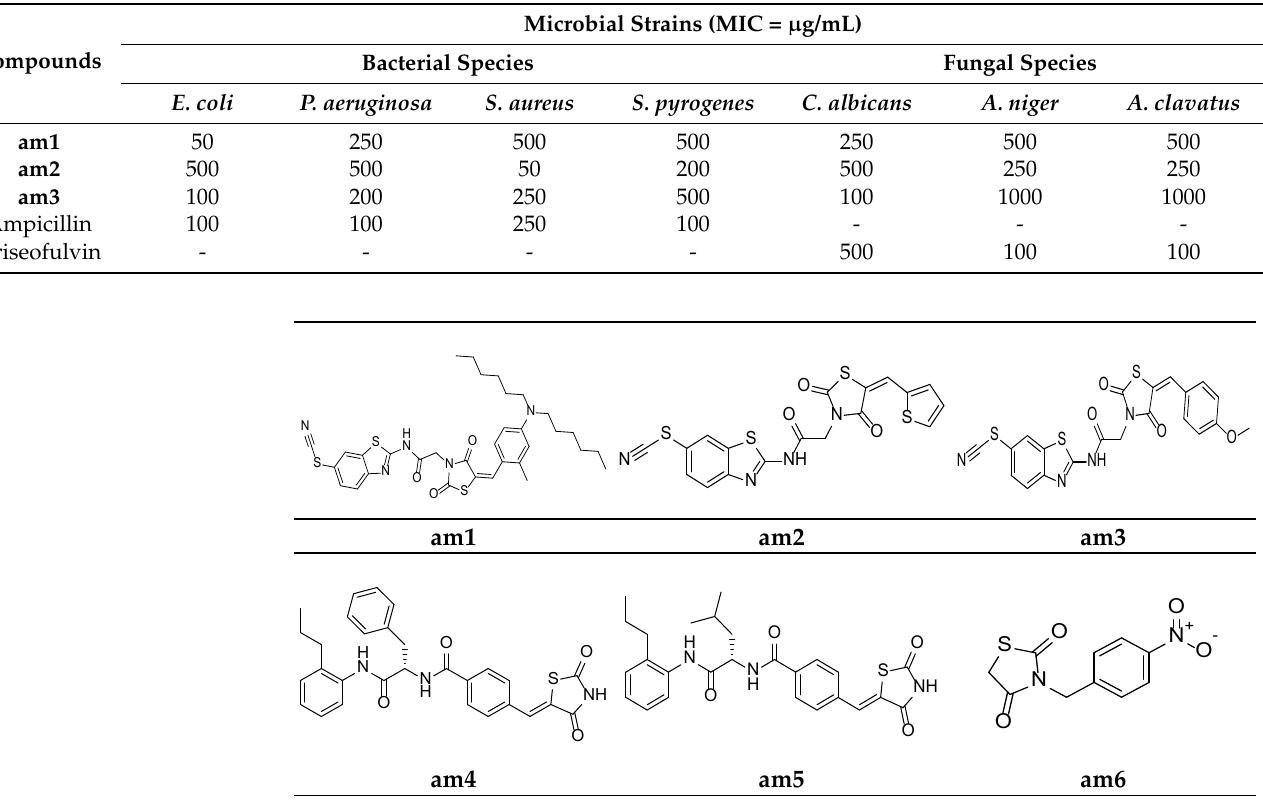
Table 2. Antimicrobial results of the compounds ( am1 – am3 ).